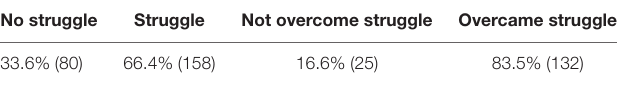
Parentheses indicate how many students were grouped into each